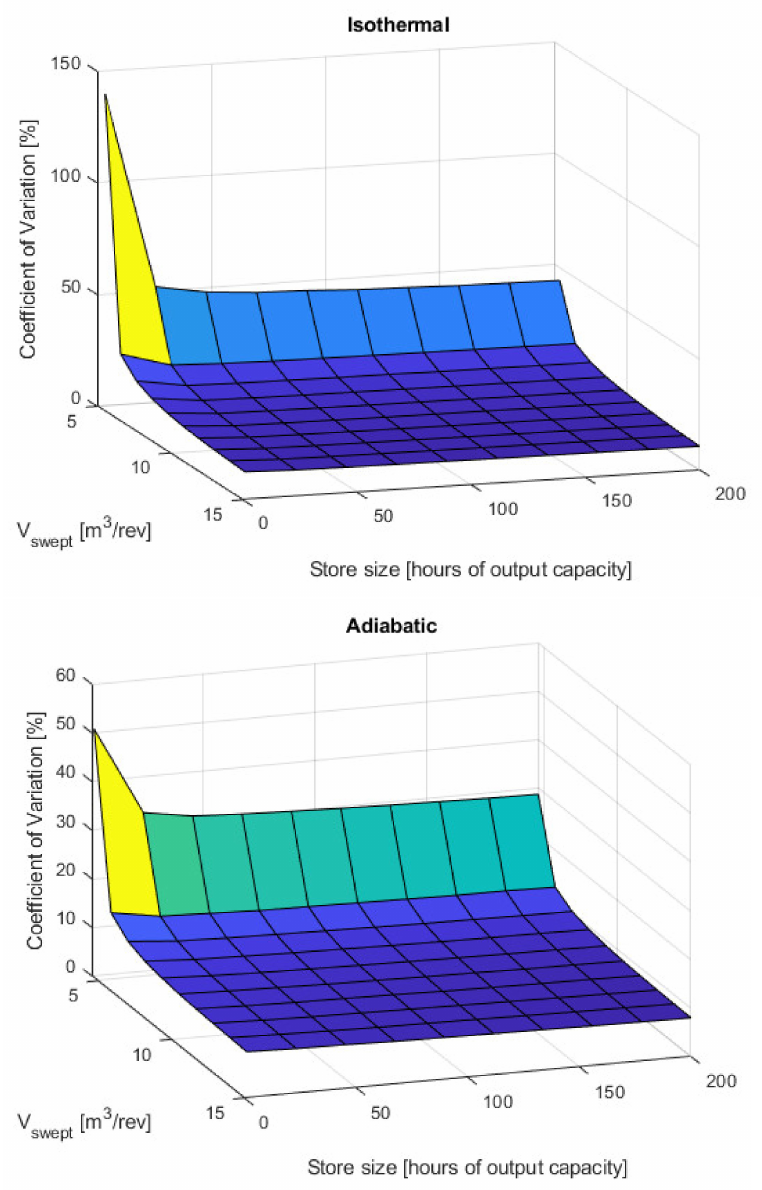
Figure 17. Results of data validation for isothermal ( above ) and adiabatic ( below ) systems, presented as the coefficient of variation of the ROI for each